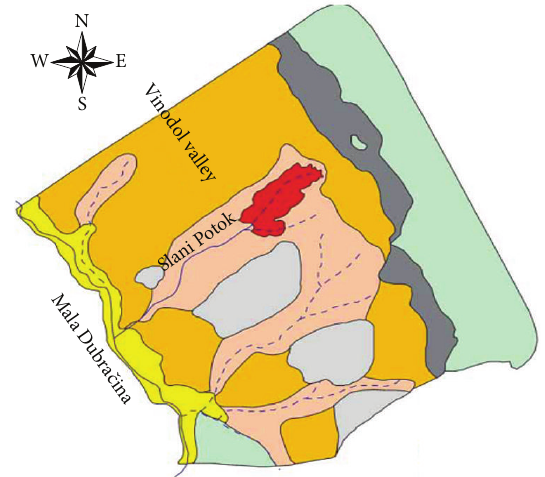
Figure 7: Schematized geologic map of the Vinodol valley with the Slani Potok catchment area [33].